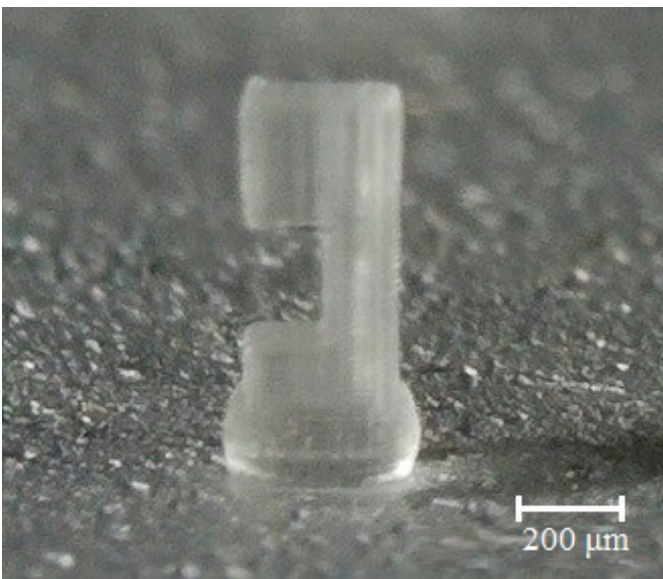
Figure 8. Image of the micro beam fabricated with the P μ SL method.